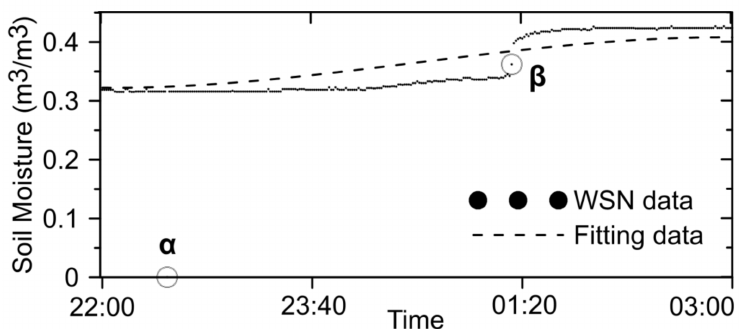
Figure 13. Detection of data exceptions using the fitting method.